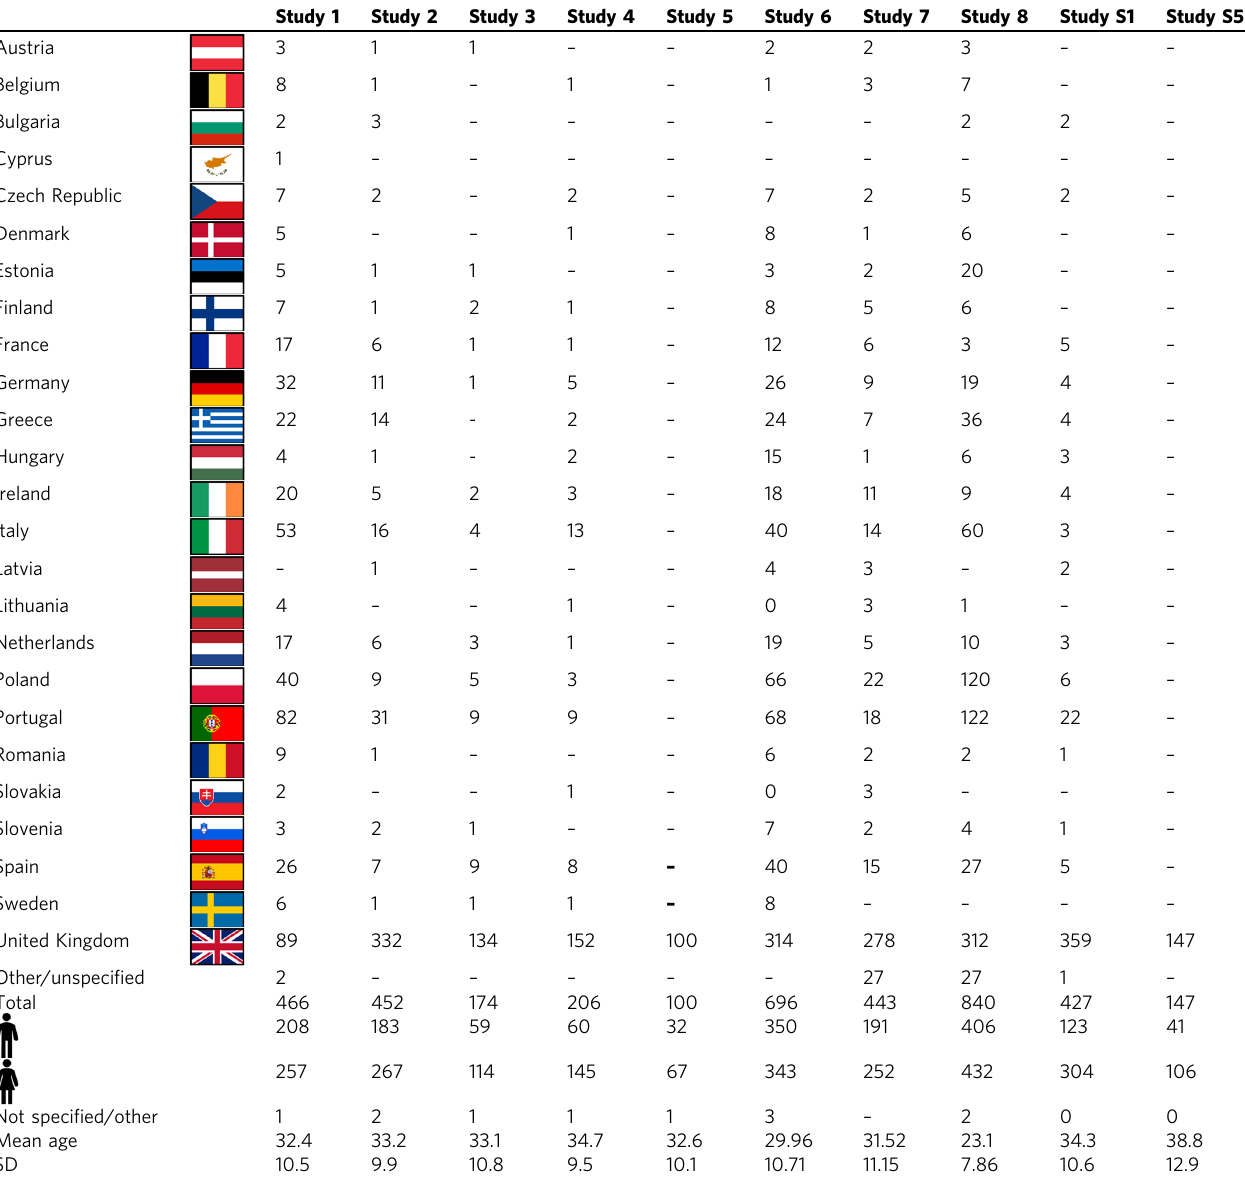
Table 2 Participants ’ nationality, gender and